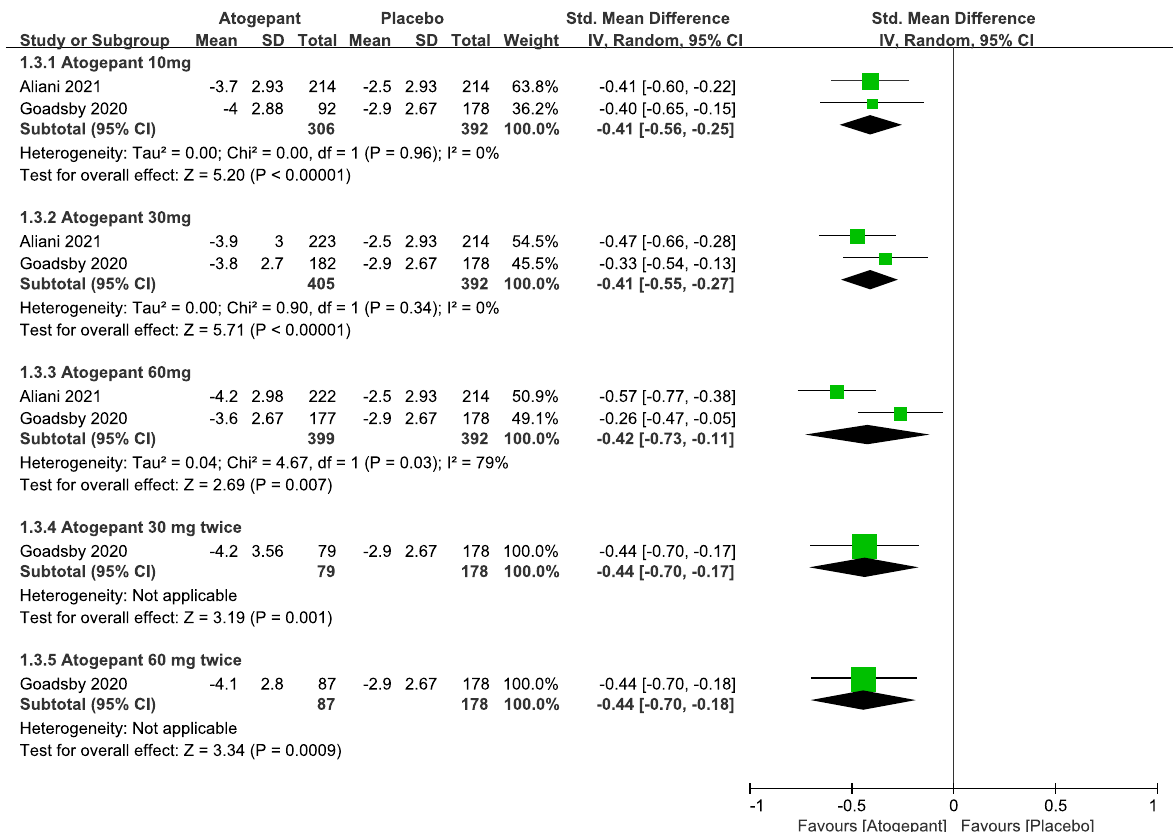
Fig. 2 The pooled SMD of monthly migraine days in different doses compared with placebo. The green square indicates the estimated SMD for each RCT. The size of green square indicates the estimated weight of each RCT, and the extending lines indicate the estimated 95% CI of SMD for each RCT. The black diamond indicates the estimated SMD (95% CI) for all patients together. CI, confidence interval; RCT, randomized controlled trial; SMD, standard mean